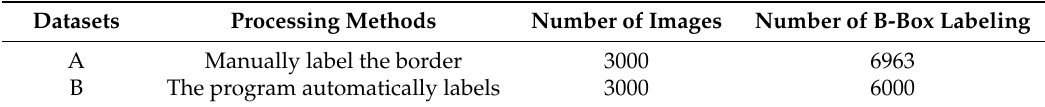
Table 2. Datasets and